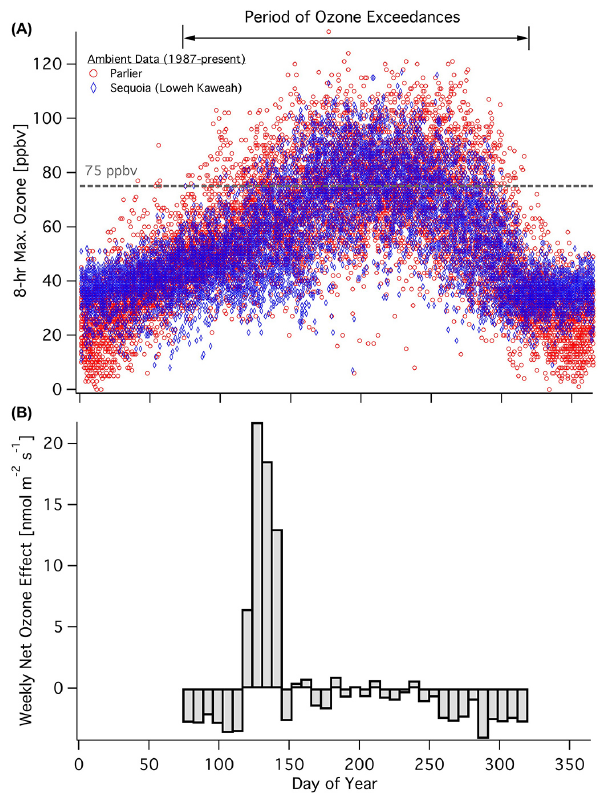
Figure 10. (A) Ambient ozone data since 1987 (CARB) show ex- ceedances above 75ppbv at both the center of the valley and down- wind in the Sierra Nevada with the primary period of concern from day 70 to 320. No trends were apparent in the data from 1987 until present. (B) The weekly net effect of the orange orchard on ozone over this period is shown to be a net source of ozone in the spring- time during flowering, and relatively neutral for most of the summer until the fall, when it becomes a